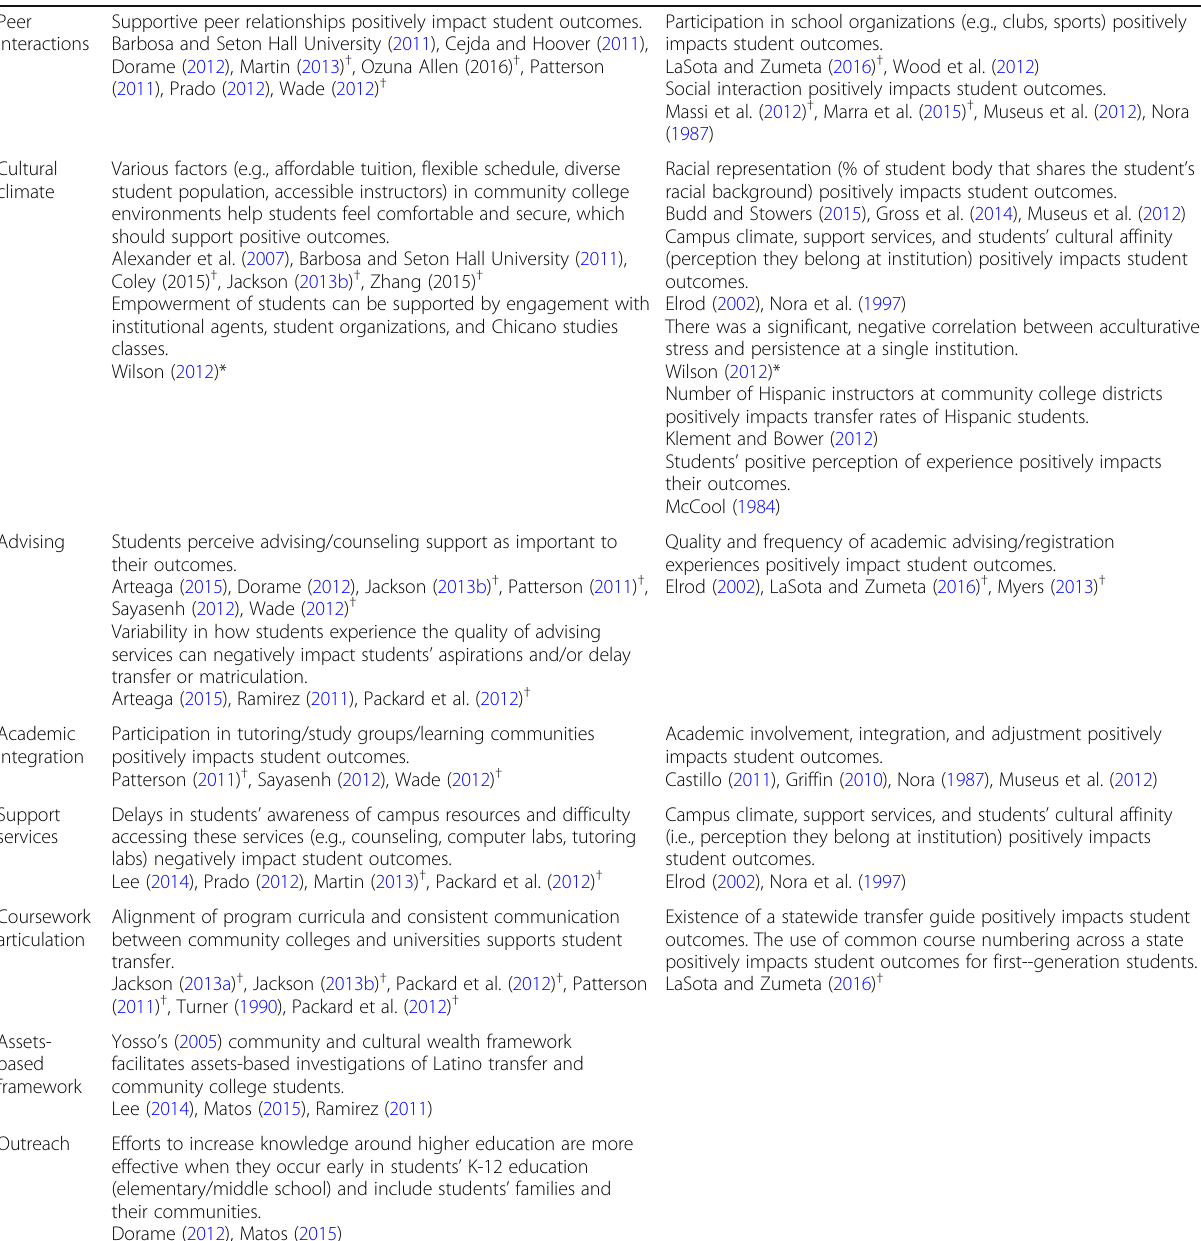
Table 3 Findings with institutions as the locus of control